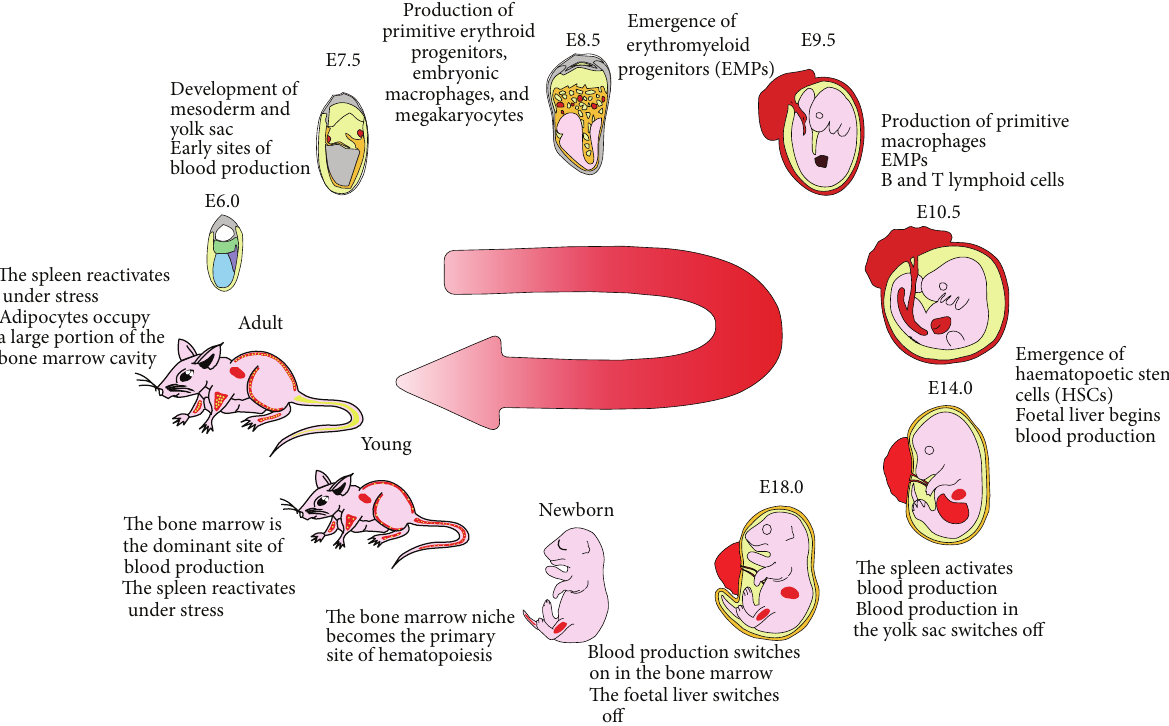
Figure 1: Timeline of haematopoiesis from early development to postnatal development in mice. This figure depicts the anatomical locations of haematopoiesis and the trafficking of haematopoietic stem cells (HSCs) and progenitor cells essential for maintaining haematopoiesis for life. Blood production begins at the mesoderm (blue, E6.0) and yolk sac (orange, all stages). From here, the first wave is initiated at the yolk sac blood islands (red, E7.0 and E8.5). Blood production is then shifted to the yolk sac and placenta (red, E9.5), with the latter providing blood to the foetus (pink) until birth. At E10.5, blood production initiates at the foetal liver and aorta-gonad-mesonephros (AGM) (red). The spleen initiates blood production at E14.0 (red) and continues to be a site of haematopoiesis after birth at time of stress. At E18.0, blood production shifts to the bone marrow (red), which remains the dominant site of haematopoiesis for life. After birth, adipocytes (yellow) begin to accumulate within the bone marrow and progressively increase as the mouse ages. Early development pictures modified from [17, 18].